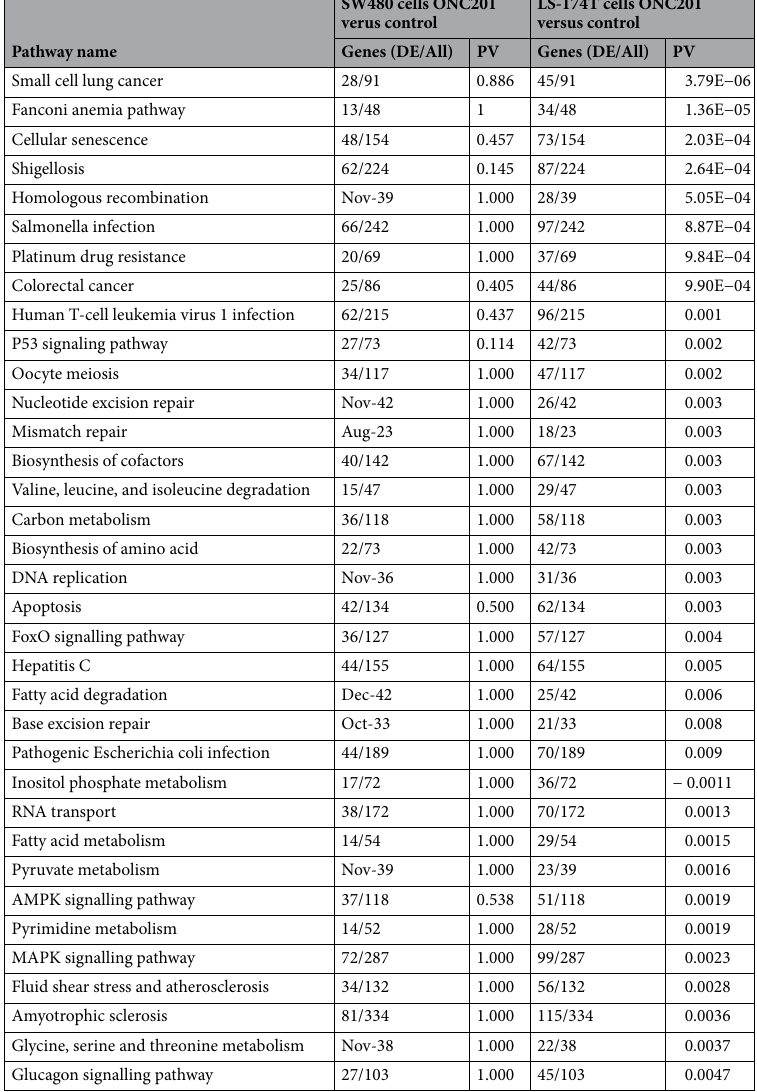
Table 1. 35 signaling pathways with significantly differentially regulated genes were observed in the metastatic LS-174T cell line. (Differential Expression/All gene detected, DE/ALL), p -value